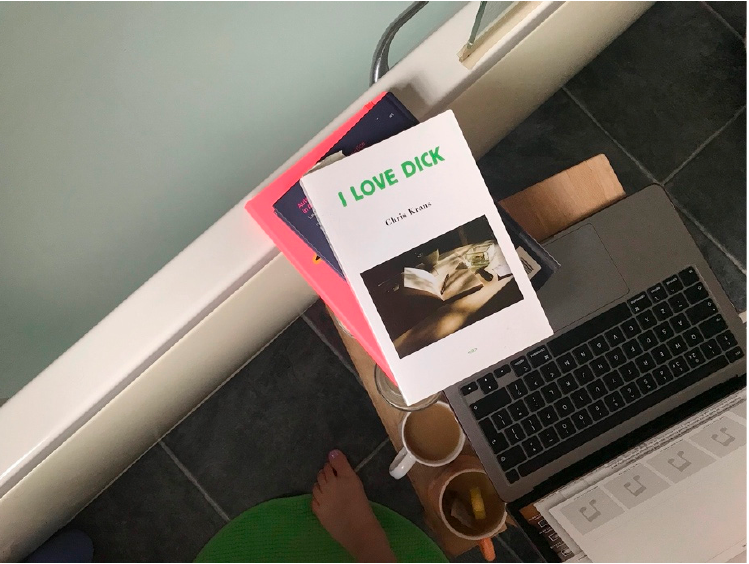
Figure 9. Episode 13 of Holding My Nerve , recorded in the bath while reading Fournier and Kraus Grace Denton and Slacks Radio, May 2022.